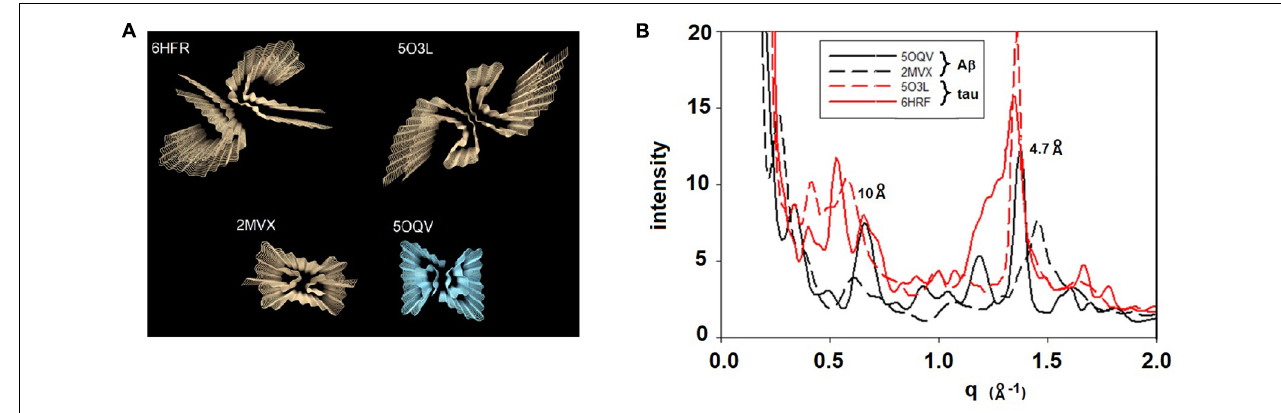
FIGURE 2 | (A) Rendering of four cross- β fibrillar structures—top two are tau structures (from PDB files 6HFR and 5O3L) and bottom two are A β structures (from PDB files 2MVX and 5OQV). (B) Scattering patterns predicted from these four structures exhibit sufficiently large differences among them that they should be distinguishable on the basis of XMD